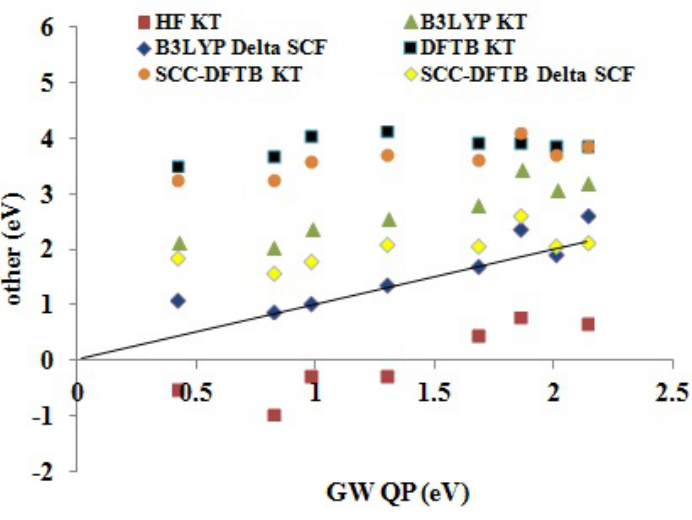
Figure 11. Correlation graph of data from Table 5 showing how the DFTB, SCC-DFTB and other methods ( y -axis, eV) compare with GW QP ( x -axis, eV)